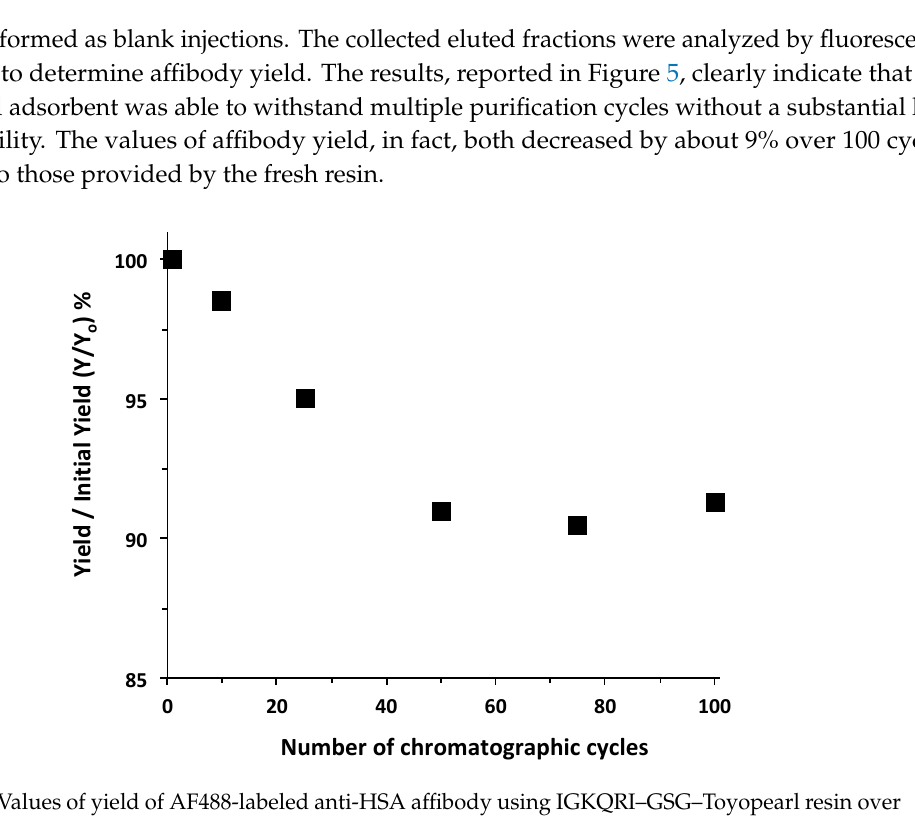
Figure 5. Values of yield of AF488-labeled anti-HSA affibody using IGKQRI–GSG–Toyopearl resin over 100 cycles.